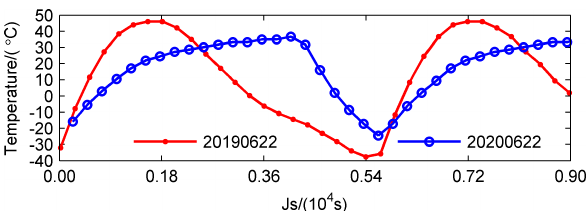
Figure 15. Temperature variations of the solar array